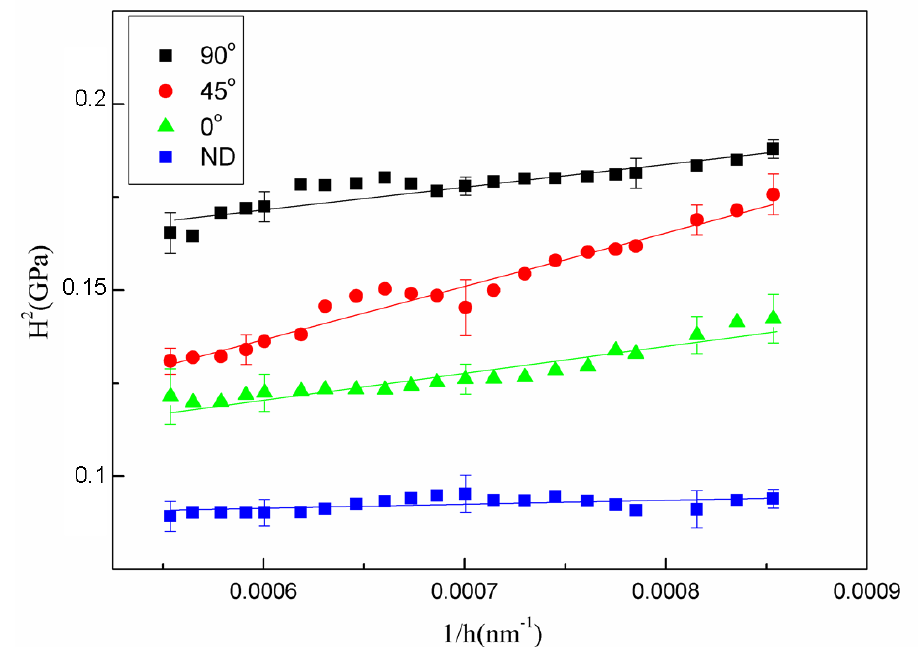
Figure 6. H 2 versus 1/ h curves of the rolled AZ31 alloys in four angles.